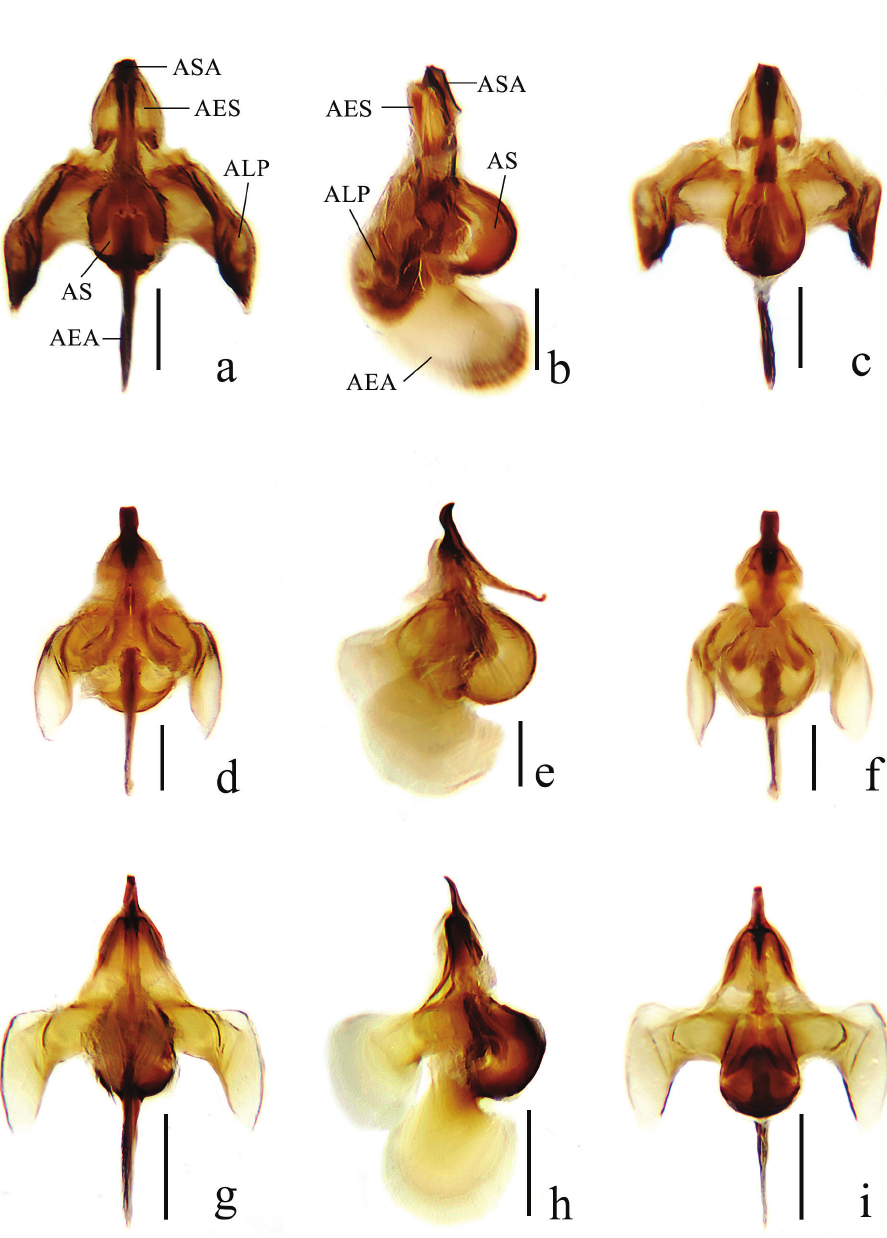
Figure 5. Aedeagi of new Ptychoptera species a P. hekouensis , dorsal view b P. hekouensis , lateral view c P. hekouensis , ventral view d P. longa , dorsal view e P. longa , lateral view f P. longa , ventral view g P. xiaohuangshana , dorsal view h P. xiaohuangshana , lateral view i P. xiaohuangshana , ventral view. Scale bars: 0.2 mm. (AEA = ejaculatory apodeme, AES = aedeagal sclerite, ALP = lateral ejaculatory process, AS = sperm sac, ASA = subapical sclerite of